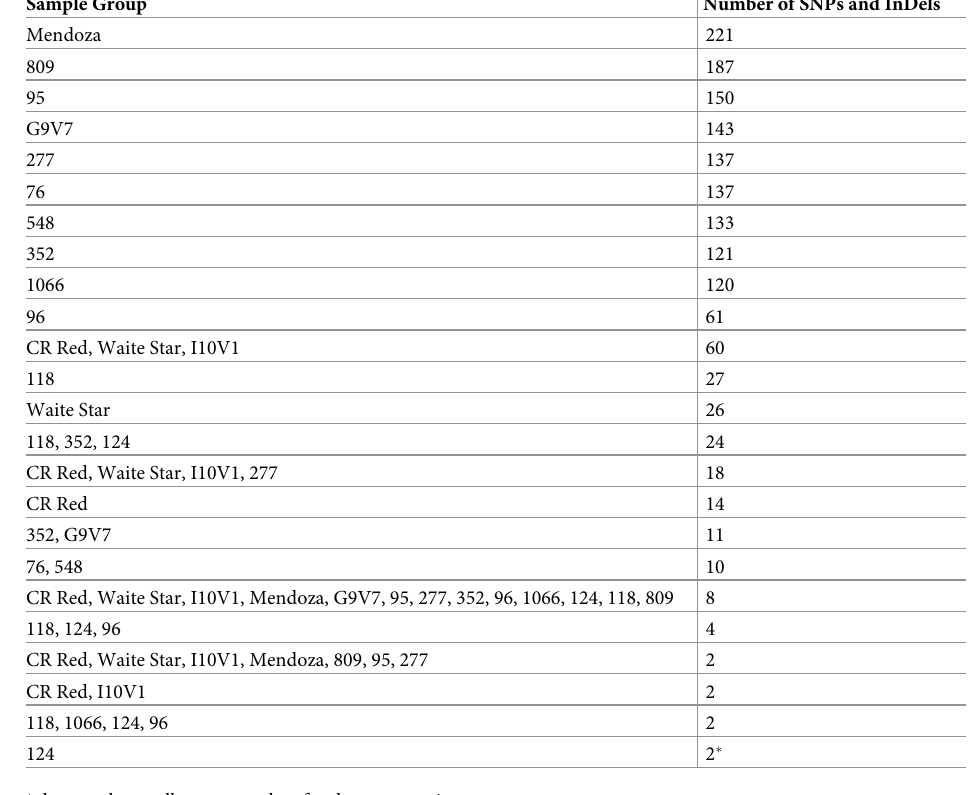
Table 2. A summary of Chardonnay clonal marker variants. Sample Group Number of SNPs and InDels Mendoza